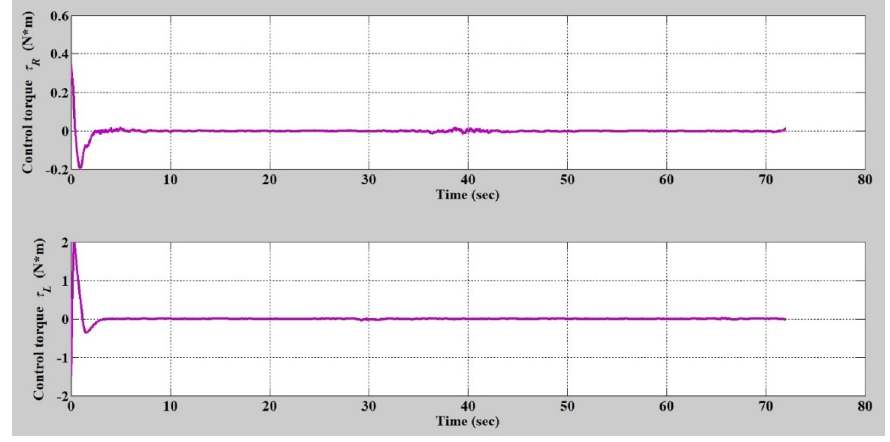
Figure 10. Results of circular trajectory tracking torques concerning initial point ( x c = 0 m, y c = − 1.9 m).